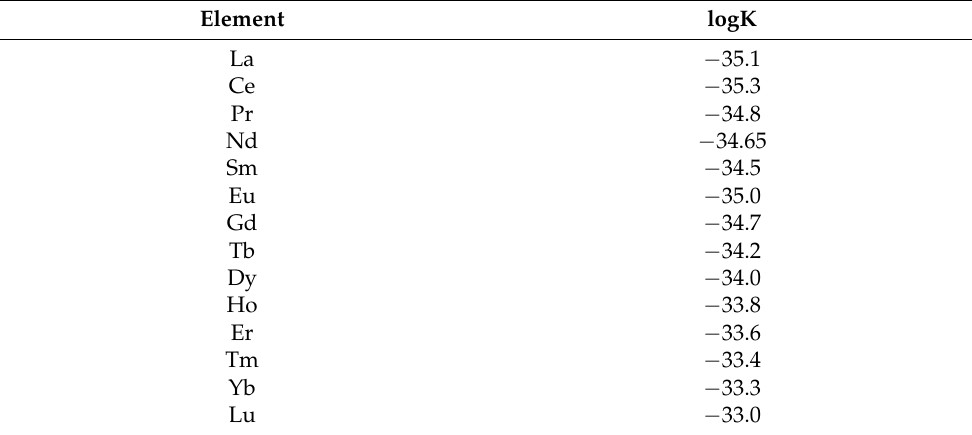
Table 1. Dissolution